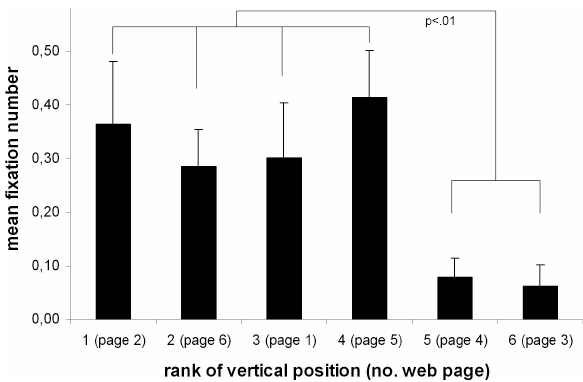
Figure 8. Mean number of fixations on an advertising element by web page. The vertical (but not horizontal) position of the element varied across web pages. Web pages are ranked (from left to right) according to the vertical position of the ad on the screen (from the upper to the lower border). The corresponding web page number is reported in brackets. Vertical lines on top of bars indicate standard error of the mean. The result of the significance test is